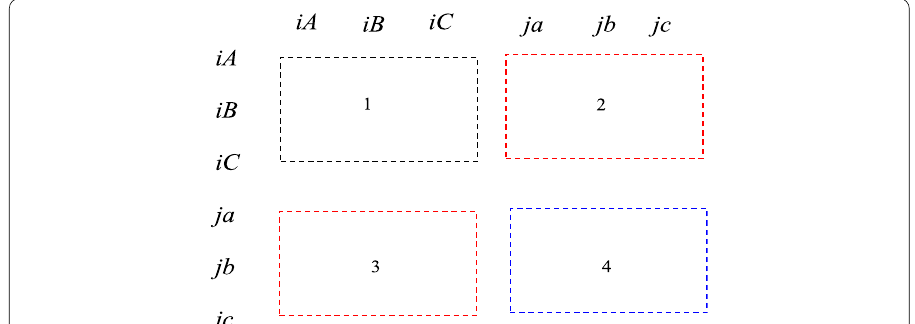
Fig. 5 Blocks of the transformer admittance matrix Y T ; the blocks of Y T are showed. The self-impedance and mutual-impedance are reflected in Block 1 on the primary side. And self-impedance and mutual-impedance are reflected in Block 4 on the secondary side. Mutual-impedance are reflected in Block 2, 3 on the primary and secondary